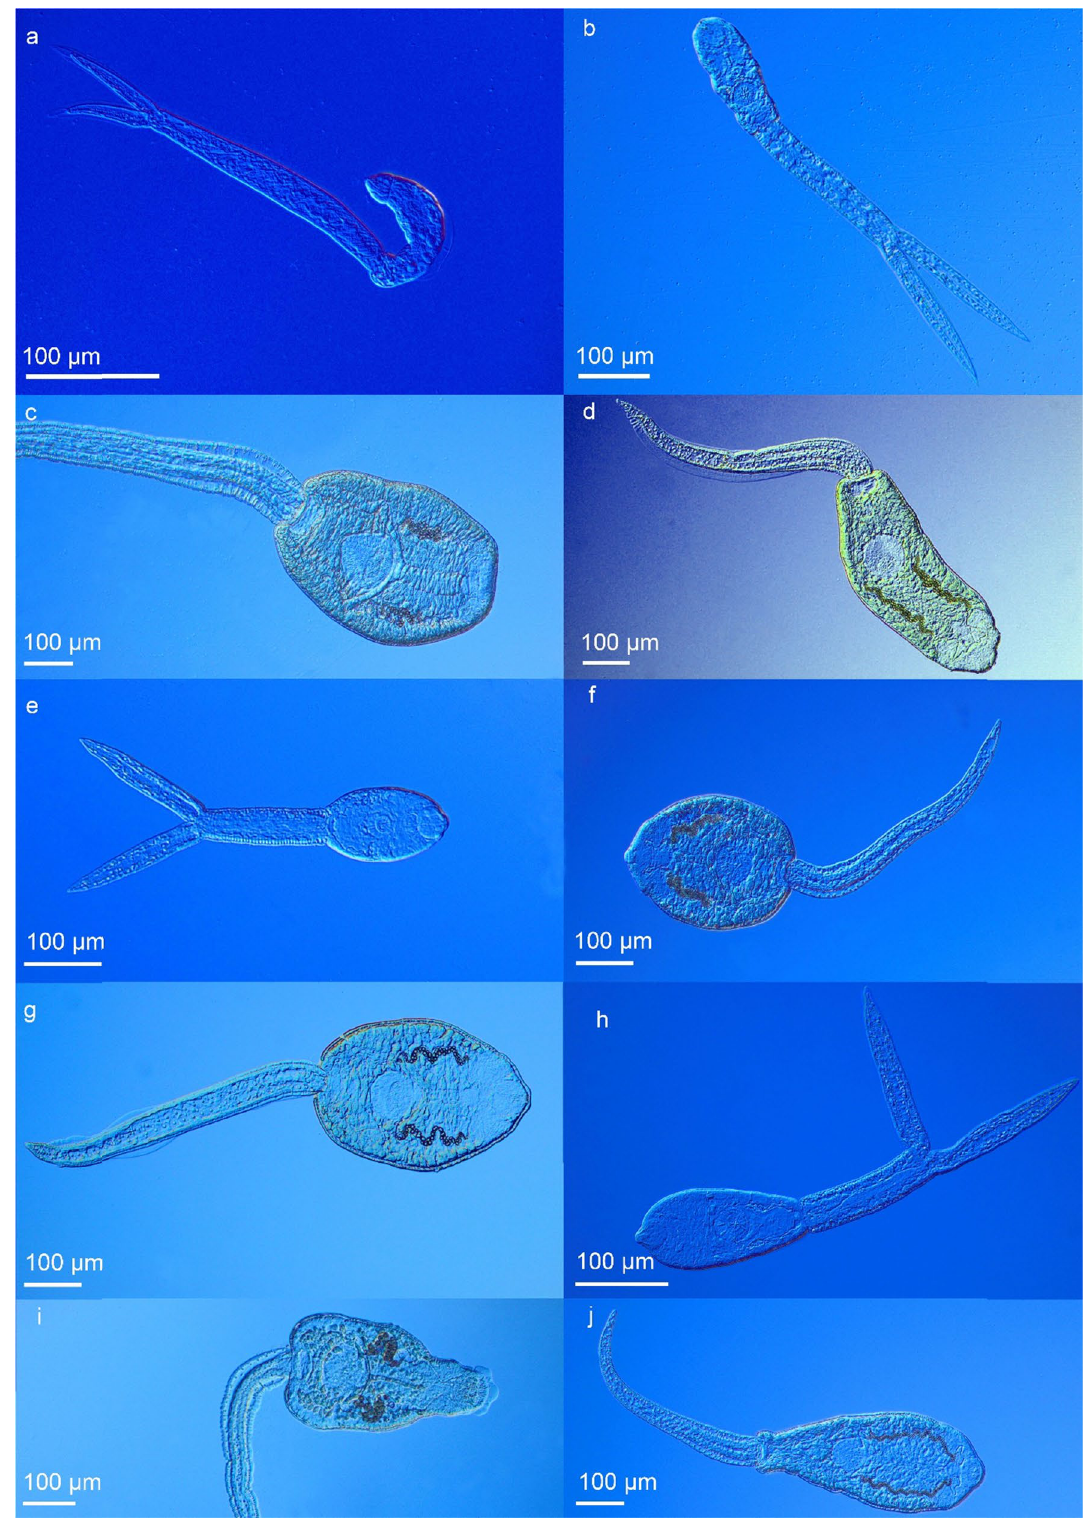
Figure 3. Microphotographs of live cercariae of the 10 most prevalent species. ( a ) Sanguinicola inermis (found 7 times). ( b ) Tylodelphis excavata (8). ( c ) Echinoparyphium aconiatum (10). ( d ) Moliniella anceps (14). ( e ) Australapatemon burti (16). ( f ) Hypoderaeum conoideum (19). ( g ) Echinostoma revolutum (38). ( h ) Cotylurus sp. (45). ( i ) Petasiger radiatus (60). ( j ) Echinoparyphium recurvatum